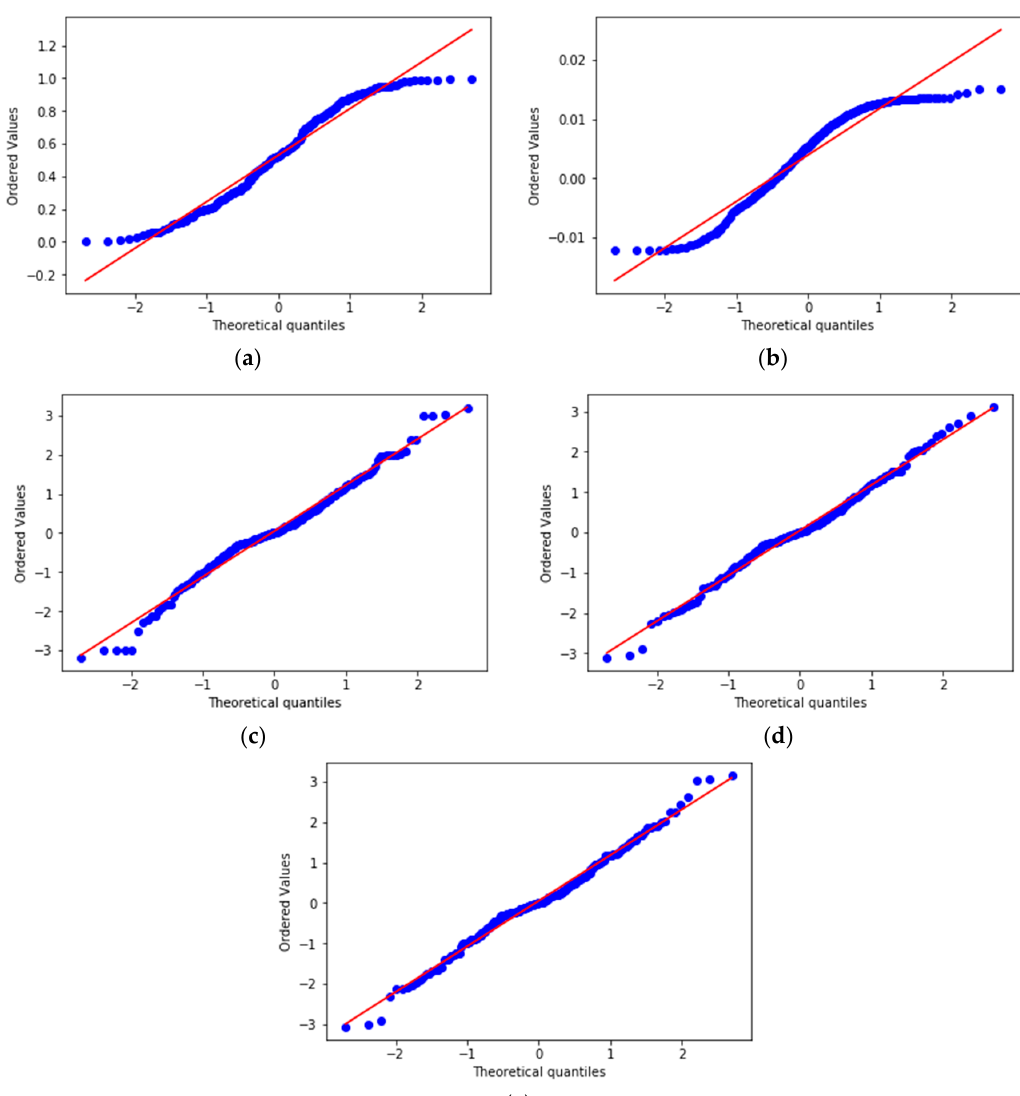
(cid:12) (cid:86) (cid:12) E [ x ]] , x : particle porosity ( a ), velocity of lixiviant (cid:12) X n − 1